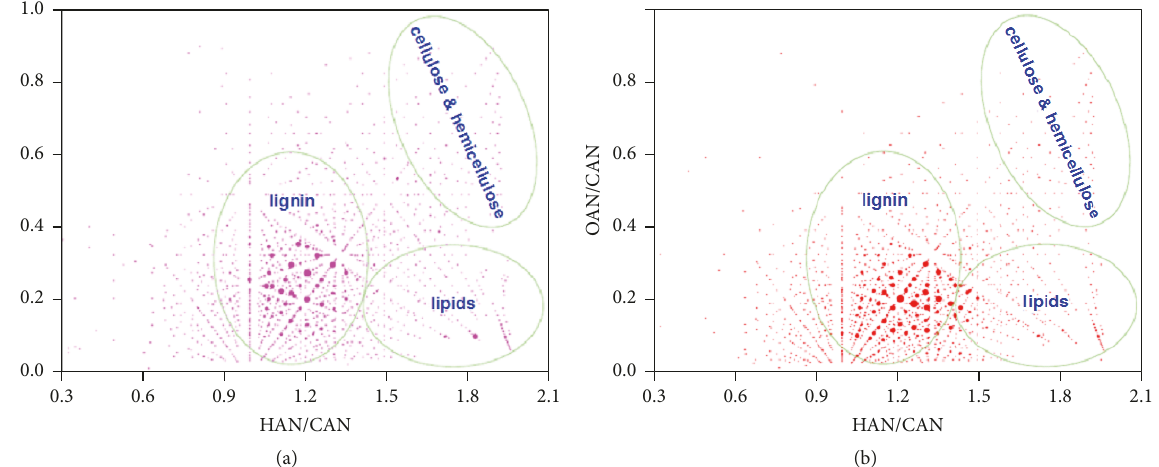
Figure 4: van Krevelen diagrams of O 𝑛 class species by negative-ion ESI FT-ICR MS analysis [28].